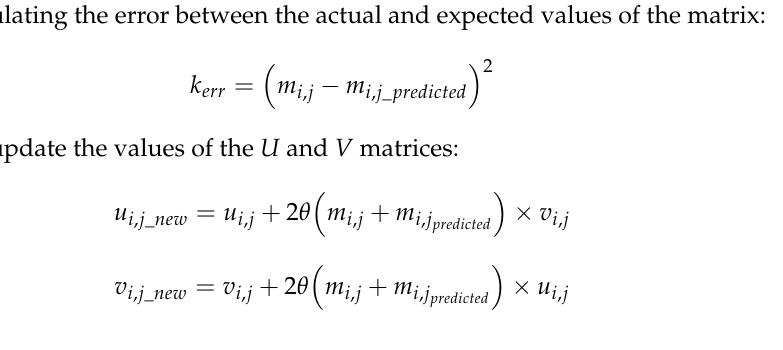
Figure 7. Recommendation accuracy dependence on data reduction.